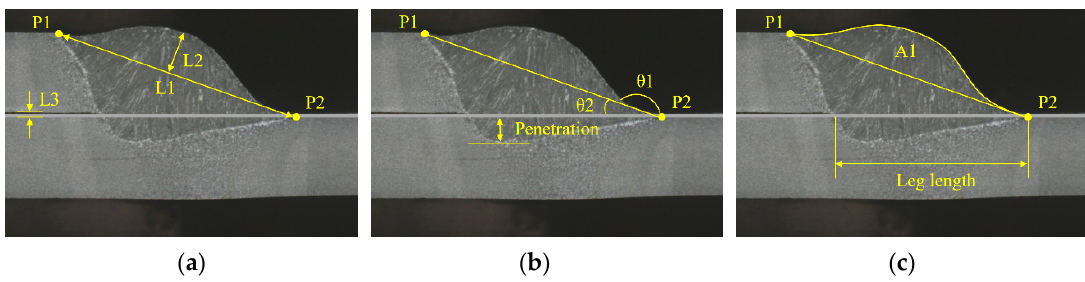
Figure 10. Weld bead parameter. ( a ) L1, L2, and L3; ( b ) θ 1, θ 2, and penetration; ( c ) A1 and leg length.